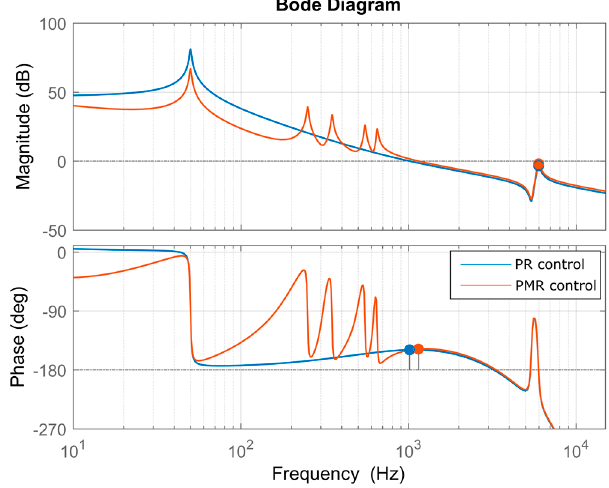
Figure 10. Bode plot of the current control open loop transfer function with proportional resonant (PR) and PMR controllers.